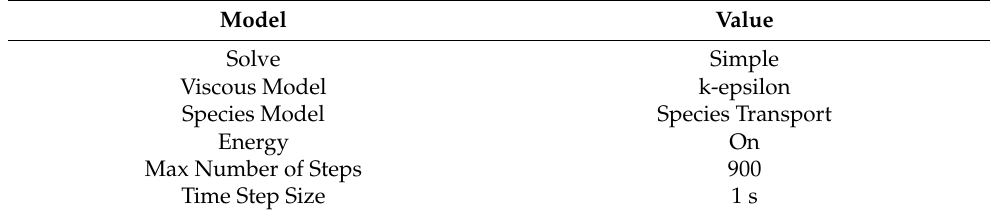
Table 11. Settings of model parameters for Test 3.